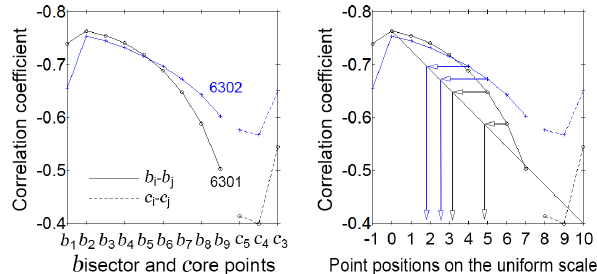
Figure 4. Left: Correlation between the v LOS and I CONT depending on the layer on which the v LOS is measured. These data are av- eraged over 8 Hinode maps for the same area 20191109_1334 – 20191109_1444, total >140000 points (points with | B > 10 G have || | been discarded). Right : Performing layer height estimation Figure 5. The effective heights of the response (indicated by inverted triangles in the graphs) were obtained as the So, using the operation shown in the Figure 4, Right , values of the centers of gravity of the resulting RF